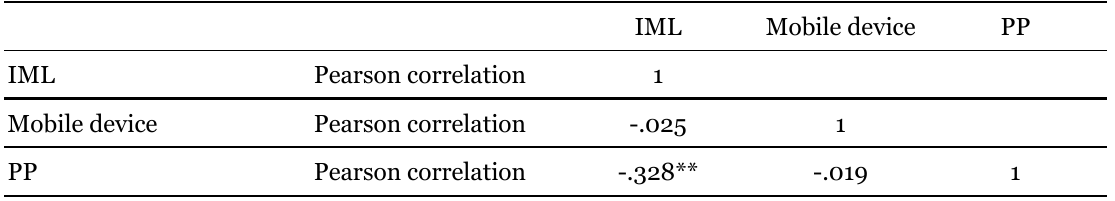
Correlation between IML, Mobile Device, and